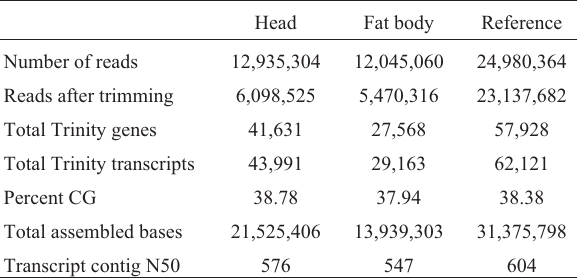
Table 1 - Summary statistics of transcriptome